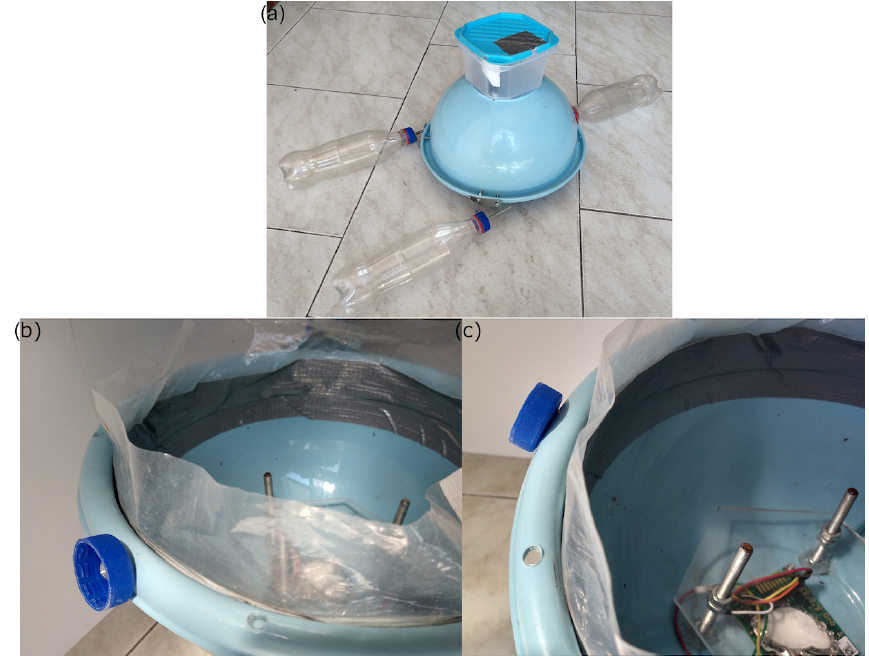
Figure C1. Overview of the flexible foil chamber (a) . Close-up of the support of the floating system (b) . Protection of the sensor from the water droplets (c)